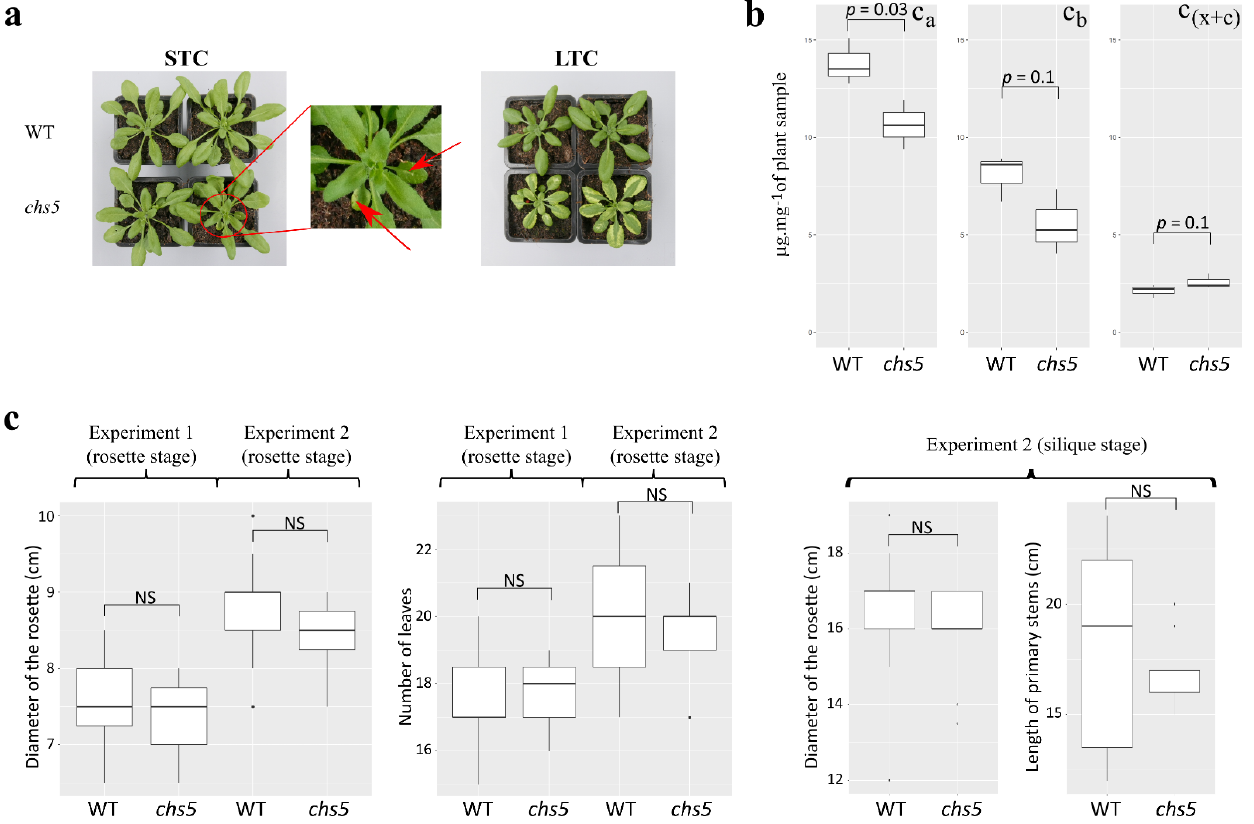
Figure 1. A. thaliana wild ‐ type ecotype Columbia ‐ 0 (WT) and chs5 mutant plants used in this study. ( a ) Plants were photographed at the fully expanded rosette stage, on day 42. STC, standard temperature condition; LTC, low ‐ temperature condition. Leaves of chs5 rosettes exhibit albino sectors in LTC whereas, in STC, chs5 rosettes were closely resembling wild ‐ type except for a very few tiny albino sectors shown in the close ‐ up. ( b ) Chlorophyll content ( μ g.mg − 1 plant sample) in wild ‐ type and chs5 plants grown in STC shown in ( a ), c a : concentration of chlorophyll a; c b : concentration of chlorophyll b; c (x+c) : concentration of xanthophylls and carotenoids. The normality and equality of variances (homoscedasticity) were verified with a Shapiro–Wilk test and a Bartlett test, respectively, and a statistical t ‐ test was performed. Details are given in the Materials and Methods section. ( c ) Morphometrics of plants grown in STC used in this study. Two experiments were performed to provide plant material for microbiota profiling. Data for both experiments (named “Experiment 1”